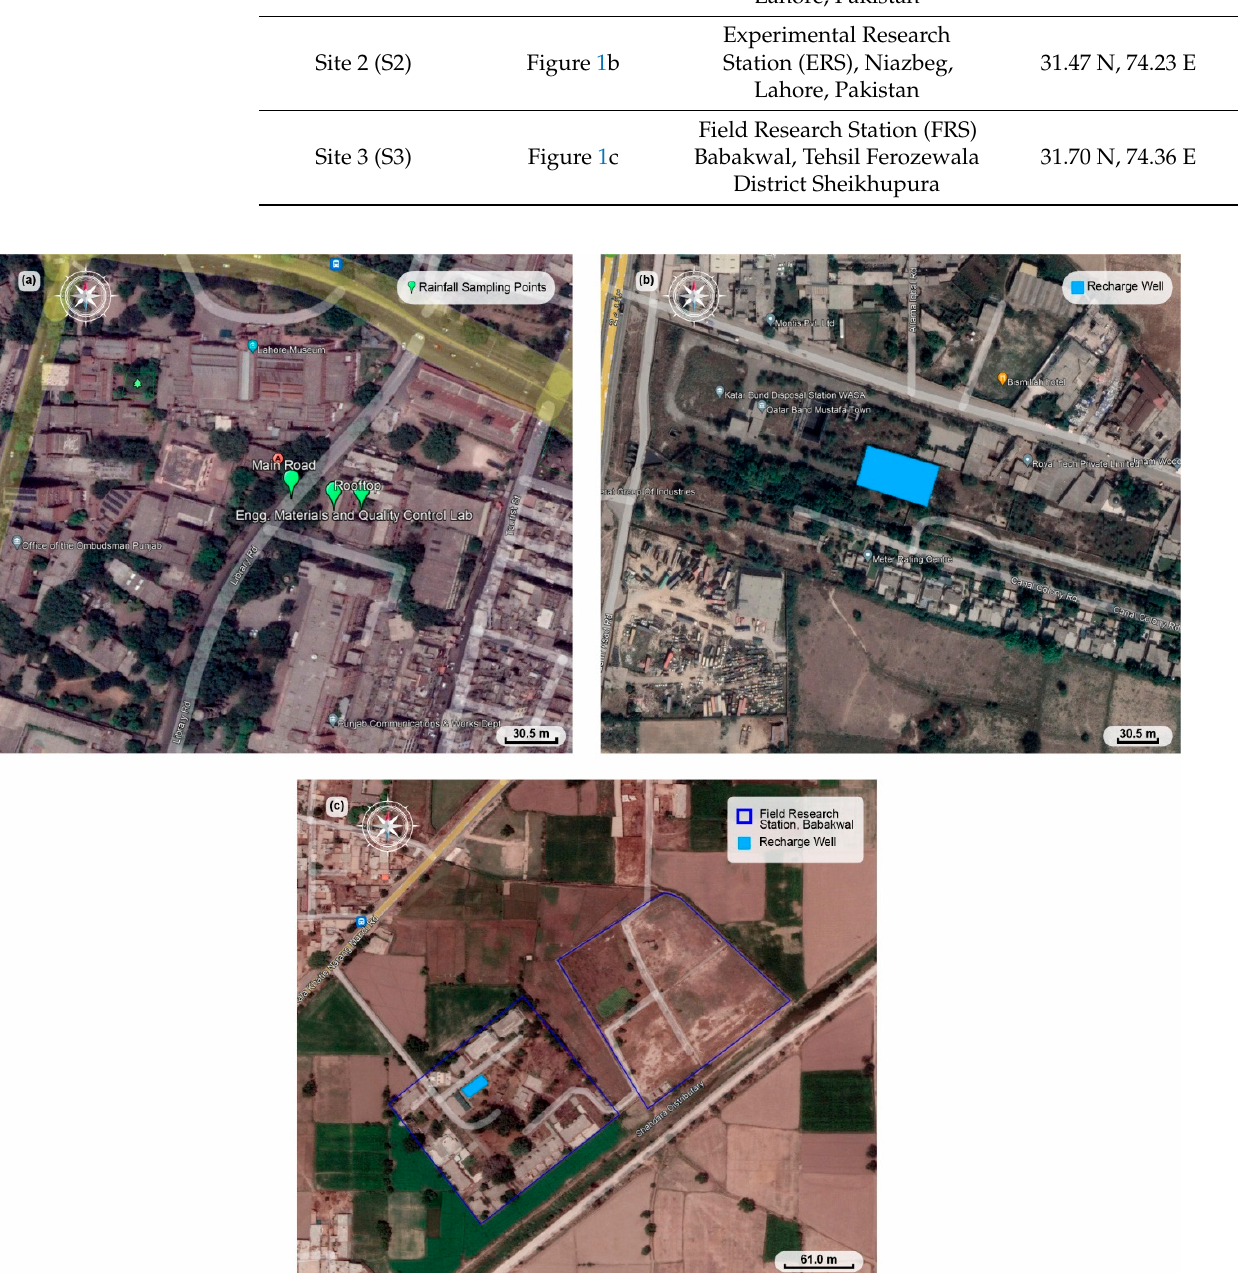
Table 1. Sample collection site locations in the study area.